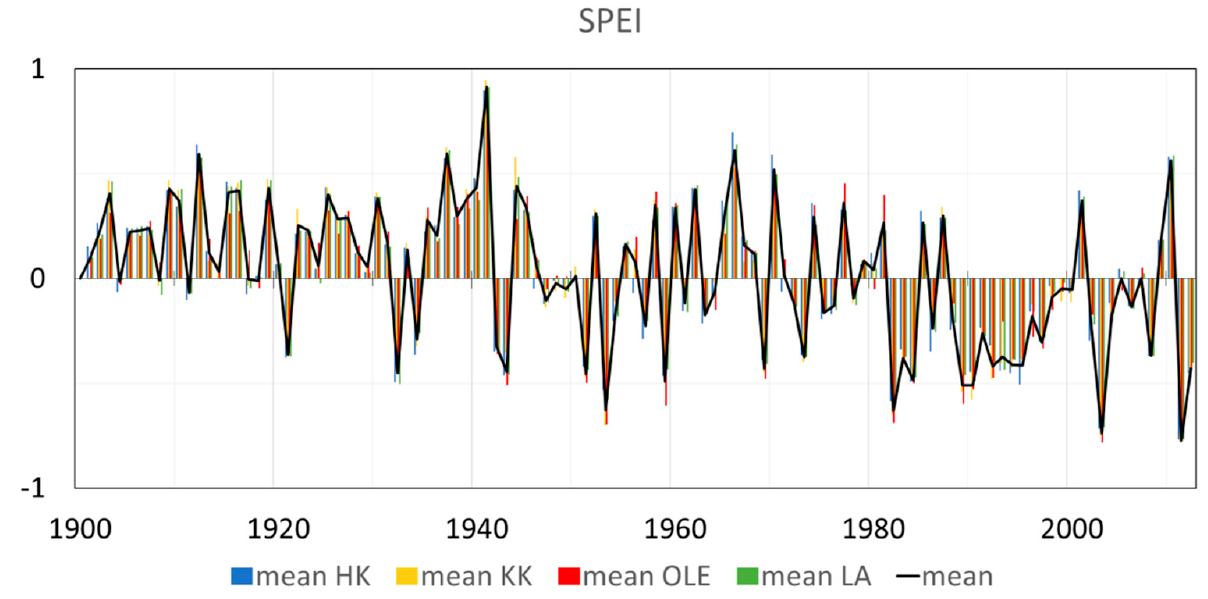
Figure 2. Comparison of time series and trends of annual mean SPEI between 4 investigated sites in Poland: HK-Dabrowa Górnicza, LA- Ł aziska Górne, KK-K ę dzierzyn Ko ź le, OLE-Olesno. Based on the data set [23,24].